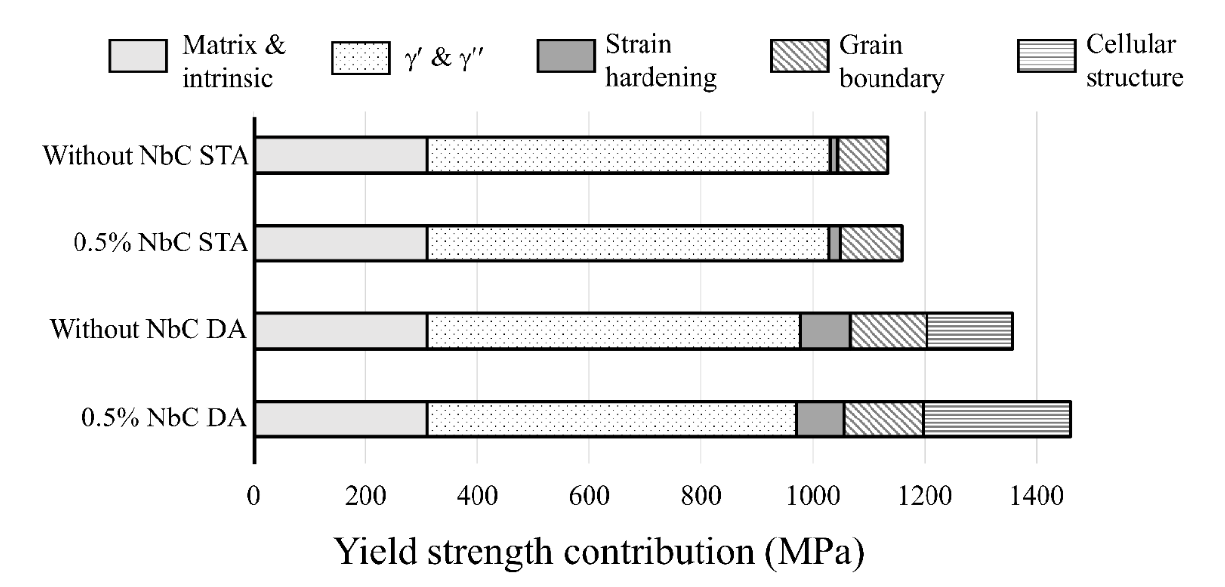
Figure 13. Contributing factors to yield strengths in samples with and without NbC addition (STA and DA heat treatments).